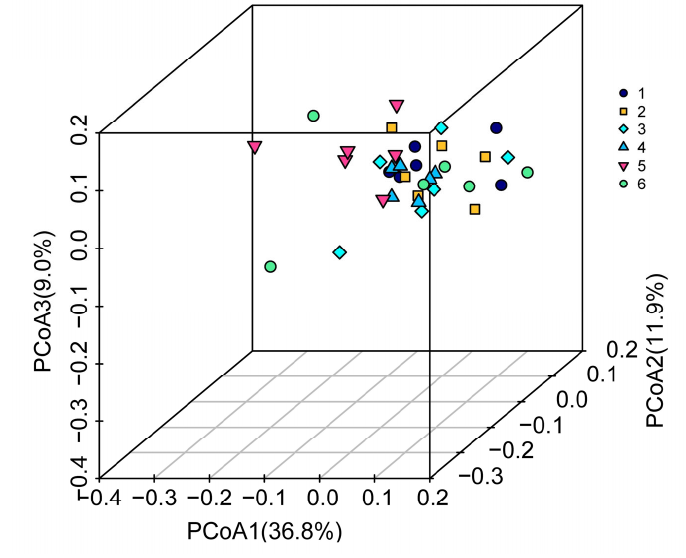
Figure 2. Multi-sample principal co-ordinate analysis (PCoA) analyses based on weighted_unifrac matrix. The three-dimensional plot was drawn by using the vegan diagram package of the R software. Dots of different colours represent samples in different groups; the higher the similarity between samples, the more aggregation in the graph. Otherwise, the lower the similarity between samples, the greater the spatial distance. 1, 2, 3, 4, 5, 6 represent the 0.18%, 0.18%+SO, 0.23%, 0.23%+SO, 0.28%, 0.28%+SO treatments, respectively. 0.18%, 0.23%, and 0.28% refer to dTry level.